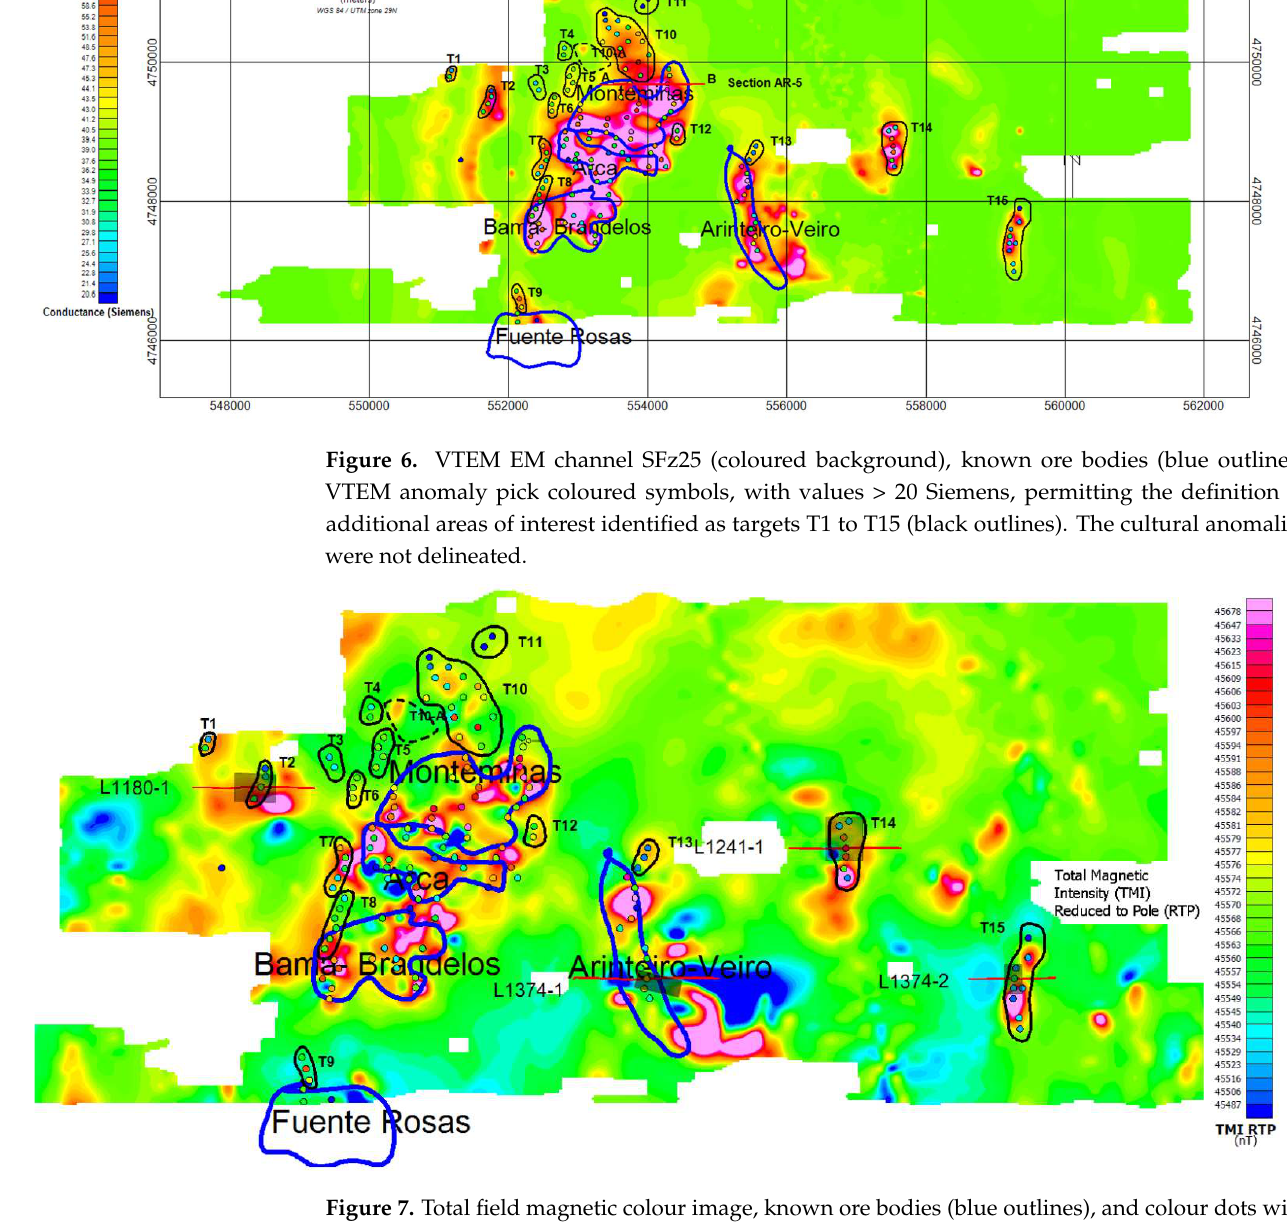
Figure 7. Total field magnetic colour image, known ore bodies (blue outlines), and colour dots with values > 20 Siemens. VTEM sections modelled in Maxwell ElectroMagnetic Imaging Technology (red horizontal line) with plates in Figures 8–11.